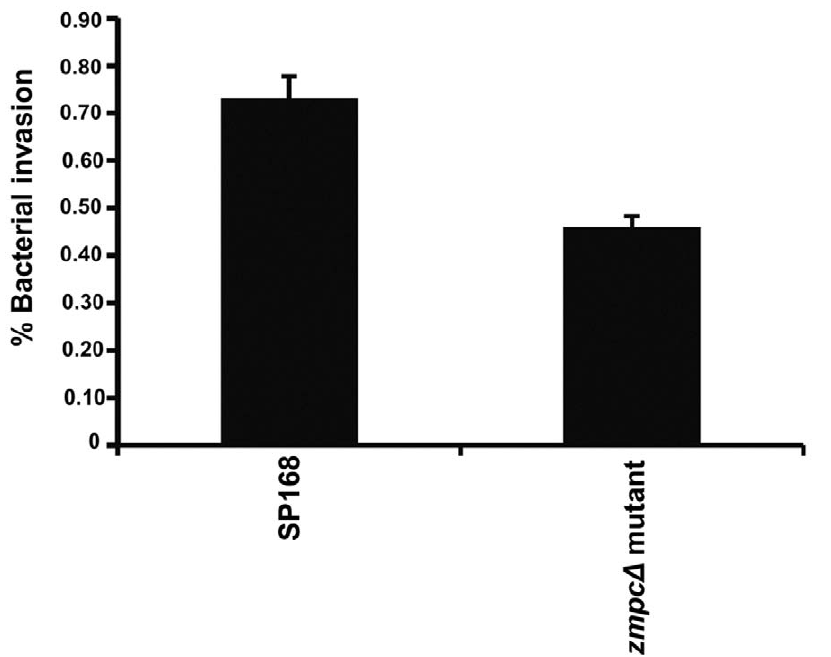
Figure 8. S.pneumonia e strain SP168 invades epithelial cells more efficiently than its isogenic zmpC D mutant. HCLE cells were incubated with SP168 and zmpC D mutant bacteria for 4 hours. Surface-bound bacteria were killed using an antibiotic protection assay. Quantitation of number of internalized bacteria was performed by serial dilutions of lysed cells and back-plating on blood agar plates. Data are expressed as a percentage of the number of bacteria recovered after the assay, divided by the initial inoculum number 6 SEM (p , 0.0001, unpaired t-test, n=6).